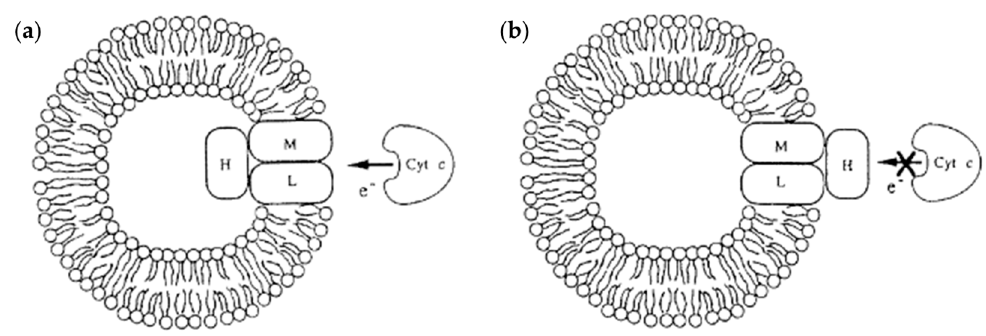
Figure 16. Orientation of RC incorporated in liposomes and determination of preserved functionality.